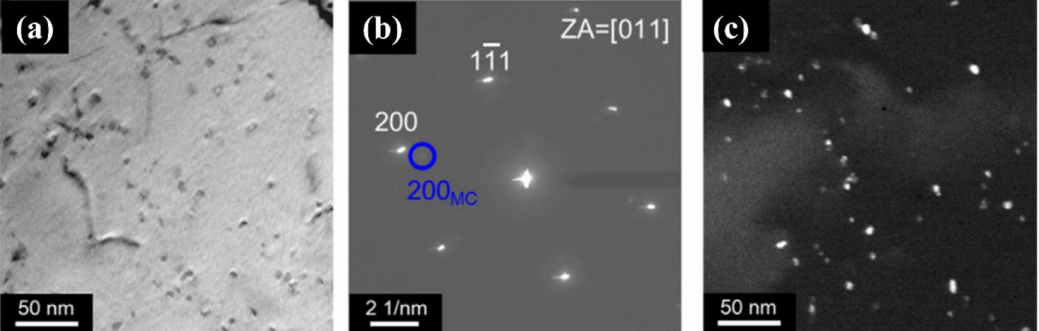
Figure 3. TEM images of AFA steel ( a – c ) after tensile testing at 700 ◦ C/strain rates of 8 × 10 − 5 s − 1 : ( a ) are bright-field images; ( b ) diffraction patterns; ( c ) dark-field images of MC